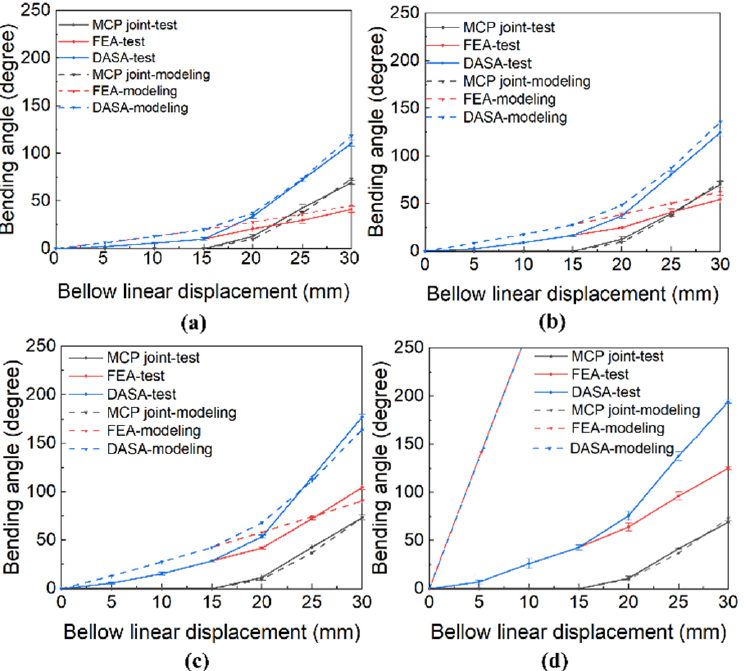
Figure 7. Experimental and modeling results of the finger bending angles vs. bellow linear displace- ment. ( a ) No water in bellow. ( b ) Half water in bellow. ( c ) Full water in bellow. ( d ) Full water in both FEA and